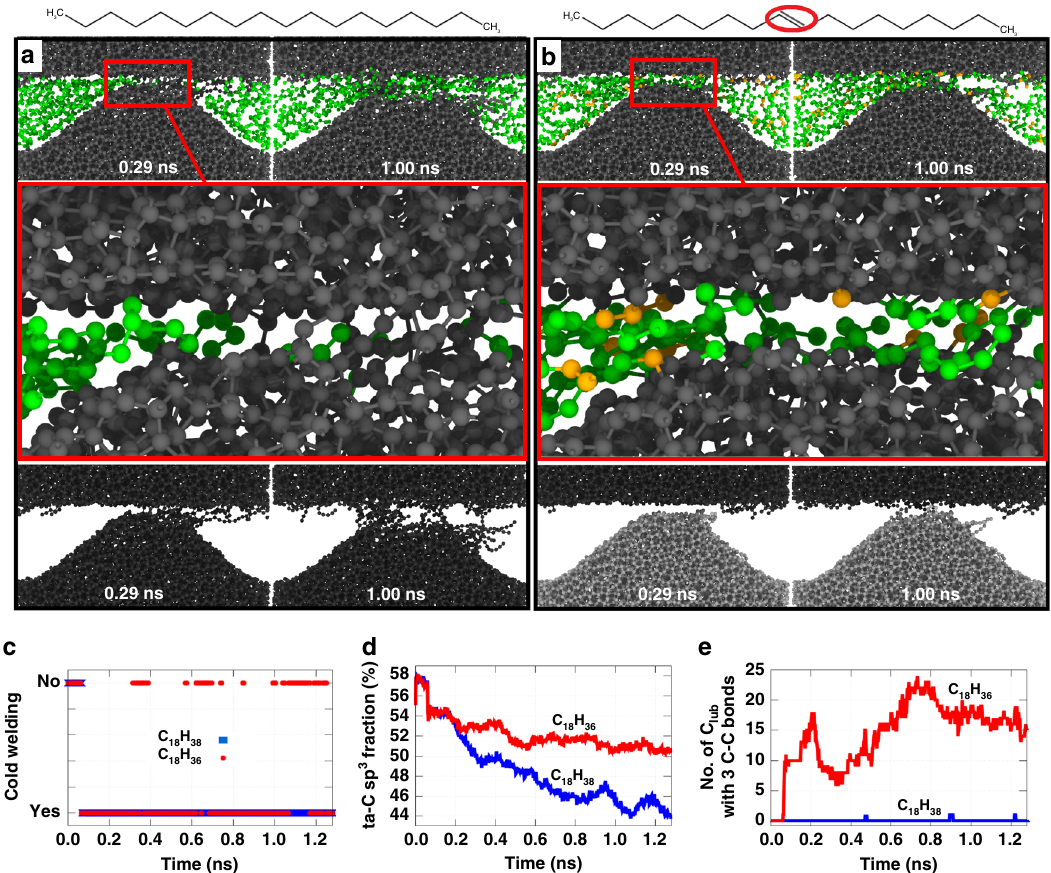
Fig. 4 Sliding of a ta-C asperity against a fl at ta-C surface. The tribocontact is lubricated with a octadecane (C 18 H 38 ) and b octadecene (C 18 H 36 ) hydrocarbons. In panels a and b , the fi rst row displays the atoms coloured according to carbon atom type: black spheres represent C atoms in ta-C; green spheres are C atoms in the lubricant; orange spheres are C atoms initially involved in C = C bonds of the octadecene. The second row represents close-up views of the regions marked with the red rectangle in the fi rst row. The third row shows the snapshots from the fi rst row without displaying the lubricant. Here, areas that are not connected by covalent bonds between ta-C atoms have different grey shades. Panel c shows the time evolution of cold welding of the two ta-C counter bodies (the chemical connection via ta-C bridges). Panel d exhibits the time evolution of the sp 3 content in the near-surface ta-C regions. Panel e displays the time evolution of the number of lubricant C atoms (C lub ) that form 3 bonds to other C atoms. These are lubricant C atoms that anchor to the ta-C